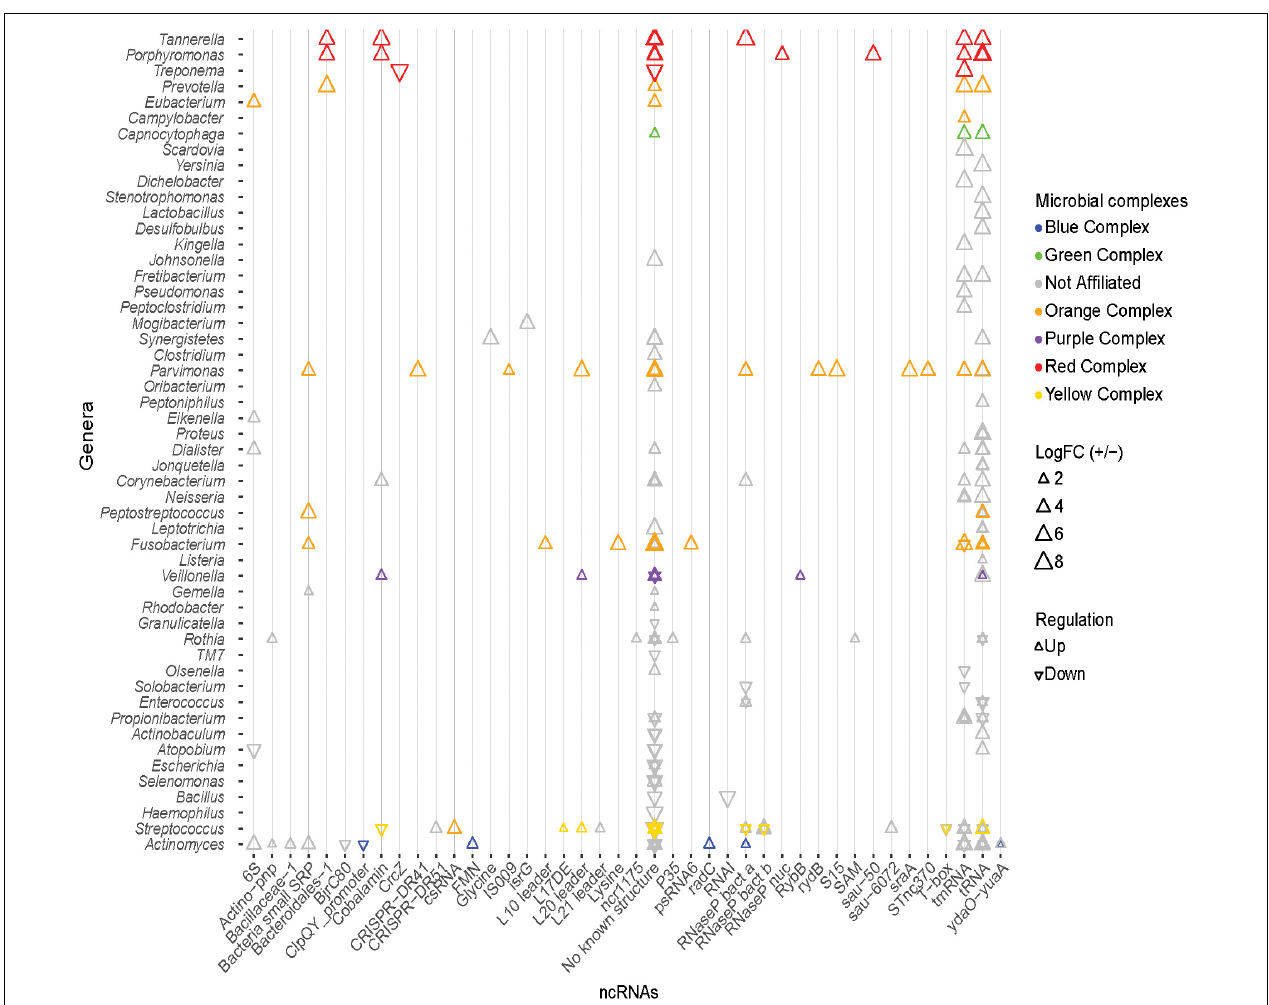
FIGURE 6 | Known ncRNAs identified in differentially expressed transcripts. Known ncRNA identified in DE transcripts, and the genus from which the ncRNA originates. Triangles colors correspond to the organism’s microbial complex, orientation depicts whether the transcript was up- or down-regulated, and the size indicates the magnitude of log 2 fold change. tRNA and tmRNA are the most abundantly identified ncRNAs. No known ncRNAs were identified in a large number of DE